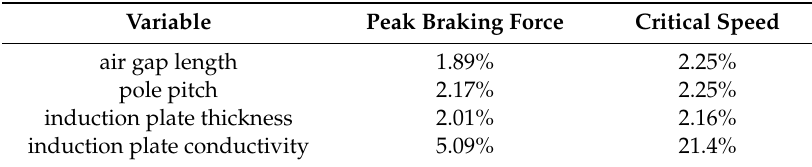
Table 3. Maximum error of the analytical solution and FEA